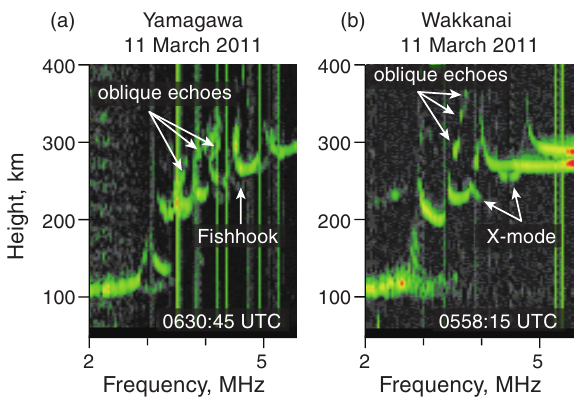
Figure 12. Ionograms obtained at Yamagawa after the M 7.7 after- shock of the 2011 Tohoku-oki earthquake (a) and at Wakkanai after the M 9.0 main shock of the same earthquake (b)